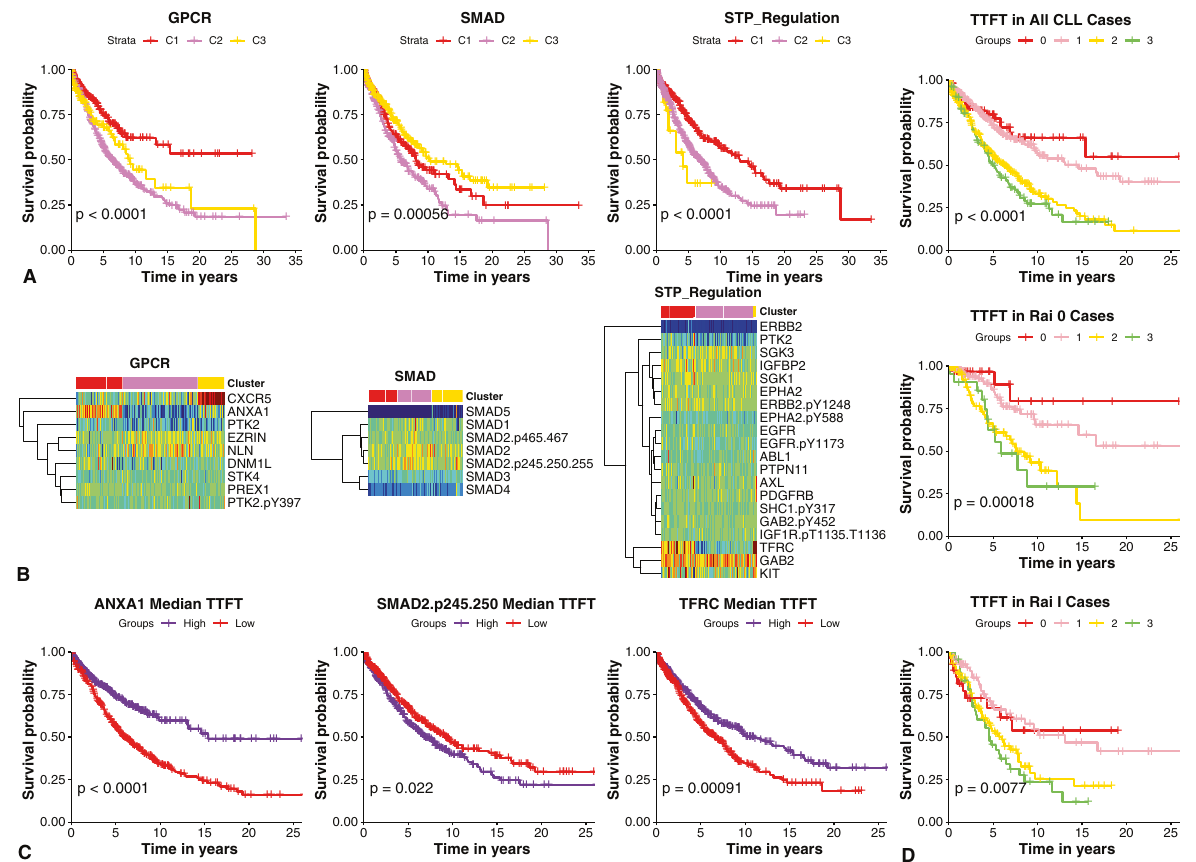
Fig. 7 TTFT outcome disparities within GPCR, SMAD, and STP-regulation PFGs. Kaplan Meier plots of PFG clusters ( A ) and heatmaps of PFG protein members expression ( B ) TTFT Kaplan Meier Plots of ANXA1, TFRC, and SMAD2.p245 strati fi ed by median ( C ). Low expression of ANXA1 and TFRC and high expression of SMAD2.p245 result in shorter TTFT. Kaplan Meier plots of the Accumulation of poor prognosis protein expression (ANXA1, SMAD2.p245, TFRC) ( D ). Groups represent the presence of 0 – 3 negative prognostic expression patterns (low ANXA1 or TFRC and high SMAD2.p245). The presence of two or more of these expression patterns results in shorter TTFT in all CLL (top), Rai stage 0 (middle), and Rai stage I (bottom)